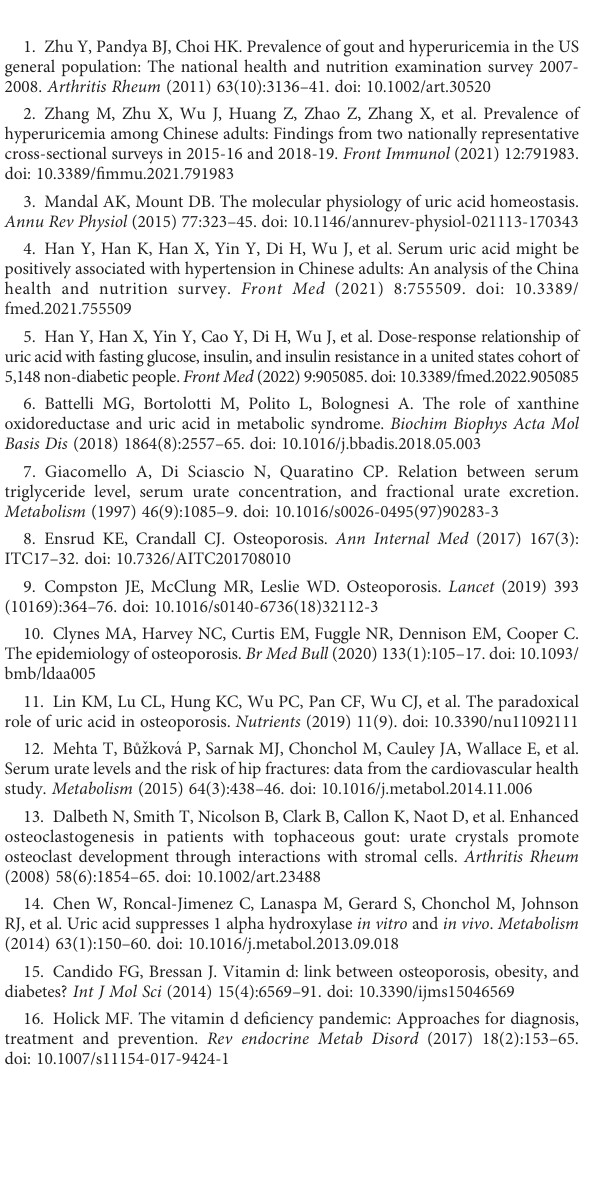
SUPPLEMENTARY FIGURE 1 (A) Funnel plots to visualize overall heterogeneity of MR estimates for the effect of serum uric acid on 25-hydroxyvitamin D. (B) Funnel plots to visualize overall heterogeneity of MR estimates for the effect of 25- hydroxyvitamin D on serum uric acid. MR, Mendelian